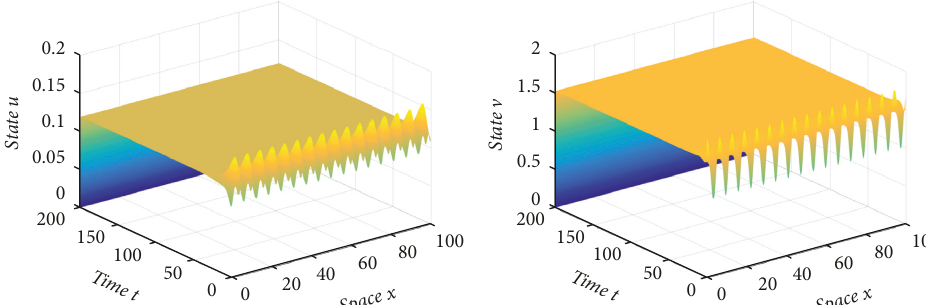
Figure 4: Spatiotemporal evolution behaviors of prey and predator of system (15) with D u ( 0 ,x ) � 0 . 119 + 0 . 1 cos x, v ( 0 ,x ) � 1 . 535 + 0 . 5 cos x .